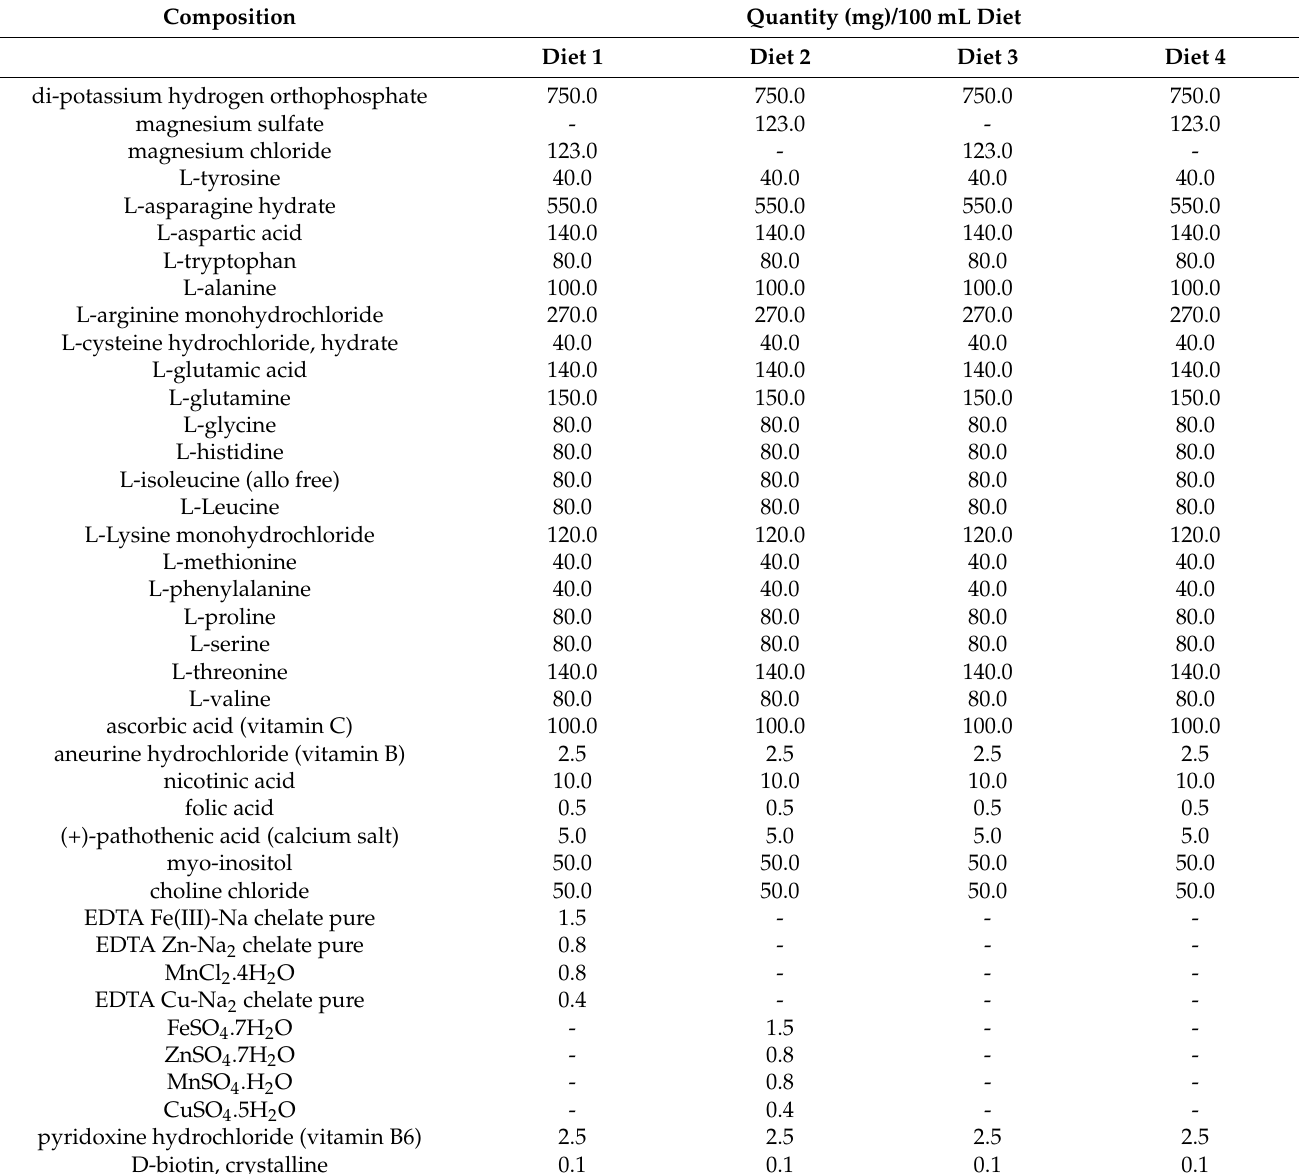
Table 3. Diet composition for banana aphid ( Pentalonia nigronervosa